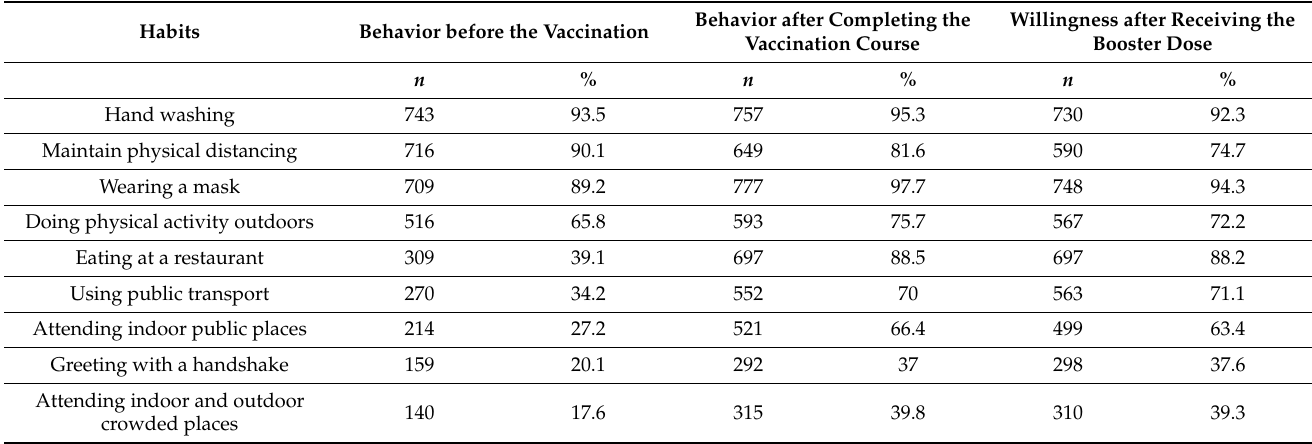
Table 3. Respondents’ behaviors regarding different habits before the vaccination, after completing the vaccination course, and willingness after receiving the booster dose of the